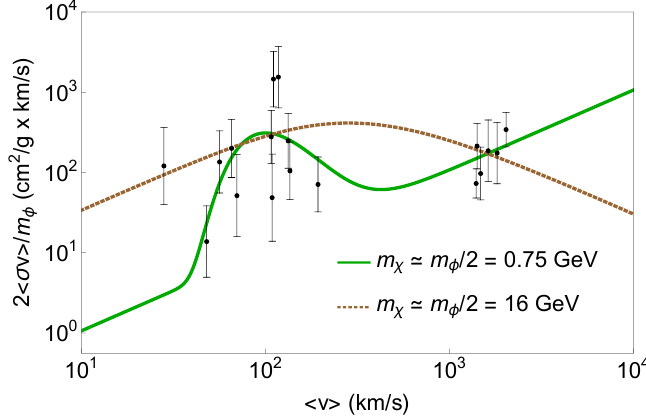
Figure 2 . The velocity-dependence of the self-scattering cross-section (times the relative velocity) predicted by the scalar dark matter: the prediction using the parameter set, ( v R , 2 σ 0 /m φ , γ φ , m φ ) = (110 km/s, 0.1 cm 2 /g, 10 − 9 . 1 , 1.5 GeV), is shown by a green solid line, while that using the set, (5035 km/s, 0, 10 − 1 . 1 , 32 GeV), is shown by a brown dashed line. The data obtained by kinematical observation is given by black dots with error bars [43] . See main text for more